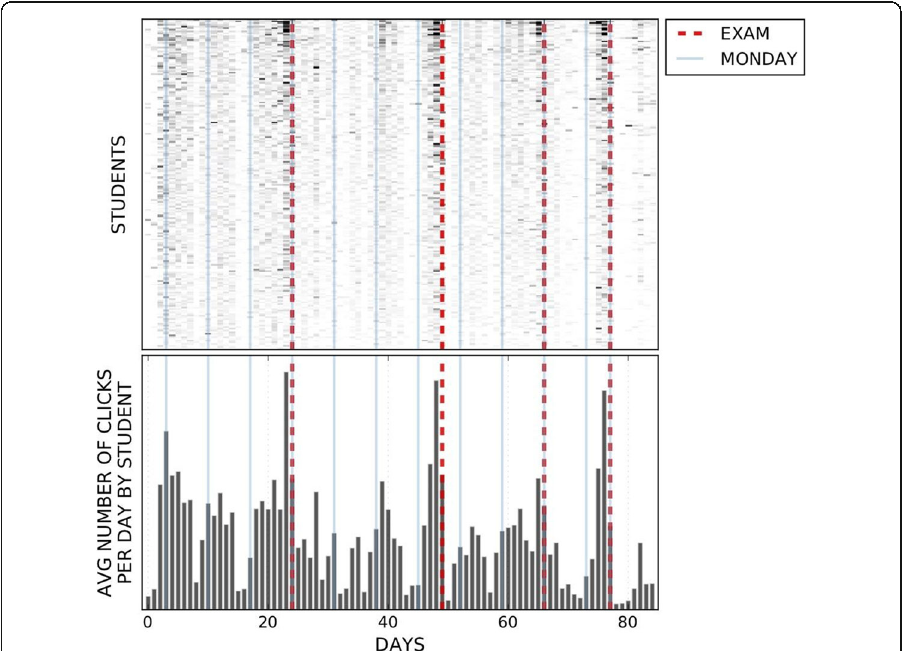
Fig. 2 Top: heat-map of daily student clickstream activity over time in a 10-week course, where the horizontal axis is in days and each row represents one student. Lighter-shaded hashes indicate fewer clicks and darker-shaded hashes indicate more clicks. Bottom: a time-series plot of the average number of clicks per day, aggregated across all students. Dates of exams and Mondays are shown in thick dashed lines and solid lines, respectively. Figure based on data and analyses in Park, Denaro, Rodriguez, Smyth, and Warschauer